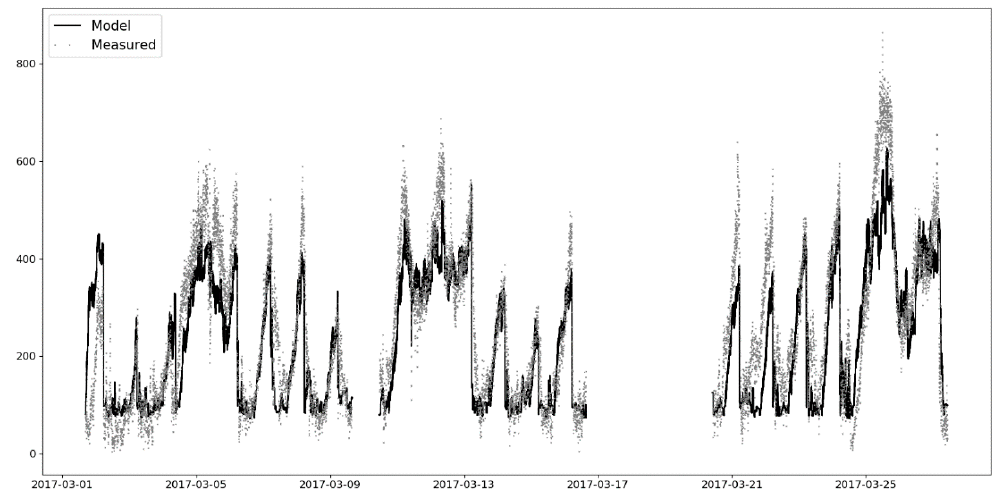
Figure 5. Comparison of an artificial neural network (ANN) model based on radon and 2 PCA particle components for School 1 (solid line) and a measurement of small ions (dotted line). Unit is [#/cm 3 ]. Training/test score 0.69/0.69.